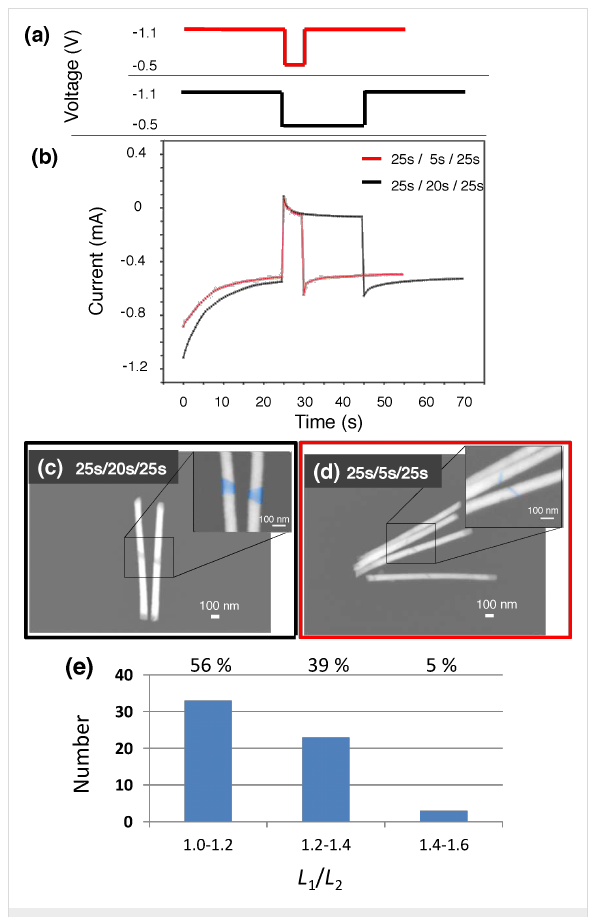
Figure 2: (a) Two pulse sequences applied for the electrodeposition of two arrays of segmented nanowires. The duration of the first and the third pulse is hold constant at 25 s, while the duration of the middle pulse is in the black curve 20 s and in the red curve 5 s and (b) corres- ponding current-versus-times curves recorded during the deposition of the nanowires. (c) and (d) SEM images of the resulting segmented wires. Image (c) corresponds to the middle pulse of 20 s and (d) to a pulse of 5 s. (e) Histogram displaying the distribution of the ratio between the length of the two Au-rich segments of the